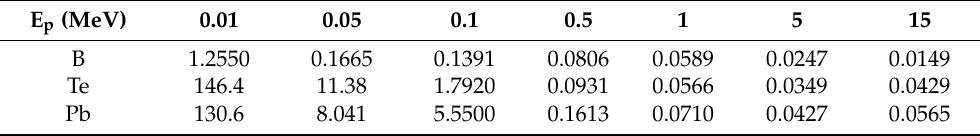
Table 3. Mass attenuation coefficient µ m (cm 2 /g) of B element, Ba element and Pb element.